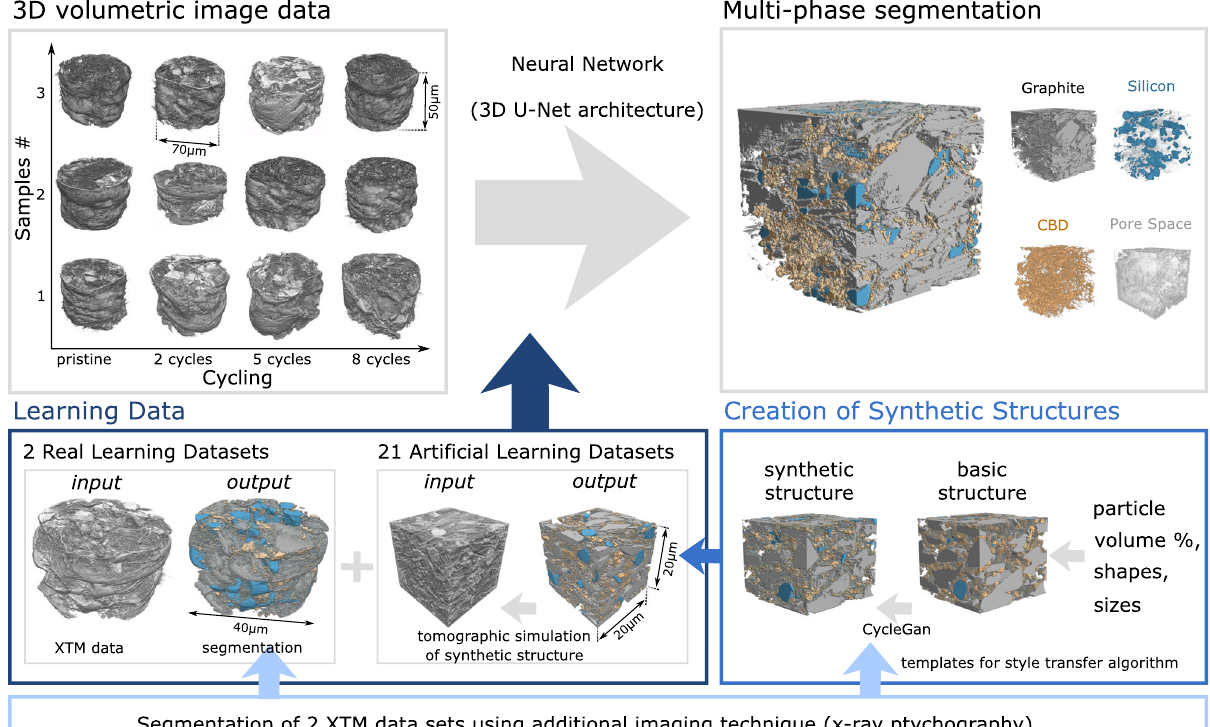
Fig. 1 Deep learning segmentation of battery electrodes. The goal of this work is to demonstrate unsupervised, learning-based segmentation of complex volumetric datasets that cannot be easily segmented using standard techniques (e.g., thresholding). We work with pristine and cycled graphite-silicon composite electrodes obtained using x-ray tomographic microscopy (XTM) and aim to segment them into four phases: pore space, graphite particles, silicon particles, and carbon black-binder domain (CBD) for statistical analysis of structural changes as a function of electrochemical cycling. For segmentation, we apply the 3D U-Net neural network architecture, that must be trained using learning data (dark blue box), which consists of volumetric image pairs (i.e., an “ input ” image like the one to be segmented and a corresponding “ output ” image, which is a segmented version of the input image). Experimental (i.e., “ real ” ) learning data is dif fi cult to obtain and requires multimodal imaging to obtain a segmented output image (see light blue box). Computationally generated (i.e., “ arti fi cial ” ) learning data can be added to the real learning data to improve the training of the network and its performance. We generate synthetic structures (blue box) by creating a basic structure based on knowledge of the volume percents and size and shape distributions of the constituent materials and then using real segmented data (light blue box) as templates for an image-to-image translation algorithm (here, CycleGAN) to create a realistic-looking, segmented structure (i.e., “ output ” image). “ Input ” images are then generated by simulating how these synthetic structures would look in our XTM measurement based on knowledge of the experimental conditions (energy, resolution,